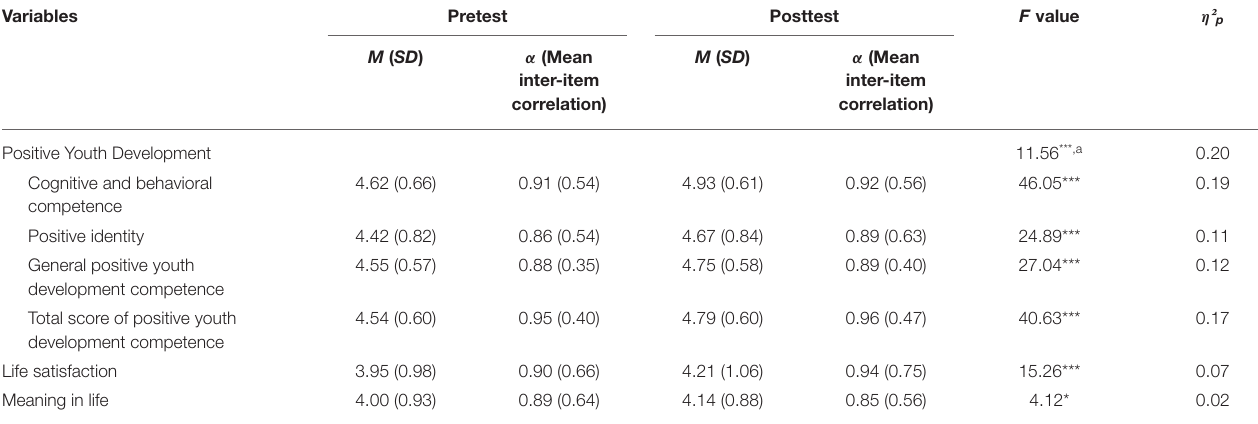
TABLE 1 | Reliability and overall changes in different outcome indicators between the pretest and posttest. Variables